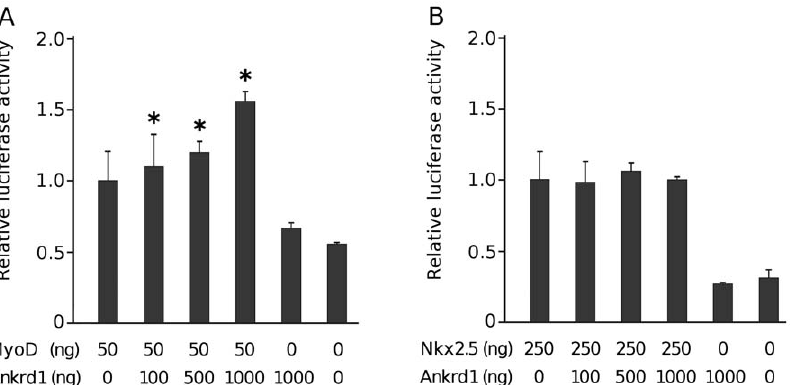
Figure 8. Ankrd1/CARP enhances the transcriptional ability of MyoD, but has no effect on Nkx2.5 induced up-regulation of the Ankrd2 promoter. C2C12 were co-transfected with both Ankrd2 ( 2 439/ + 7)-LUC and Renilla luciferase reporter plasmids as well as a constant amount of MyoD-pCDNA3 (A) or Nkx2.5-pCDNA3 (B), along with increasing amounts of an expression vector for Ankrd1/CARP, as indicated. In each assay the amount of total DNA used in transfections was kept constant by the addition of pCDNA3 vector. The firefly luciferase activity was normalized against Renilla luciferase. The histograms show the mean of at least three independent experiments performed in triplicate; the bars indicate the standard deviation. *p , 0.05 versus control sample.